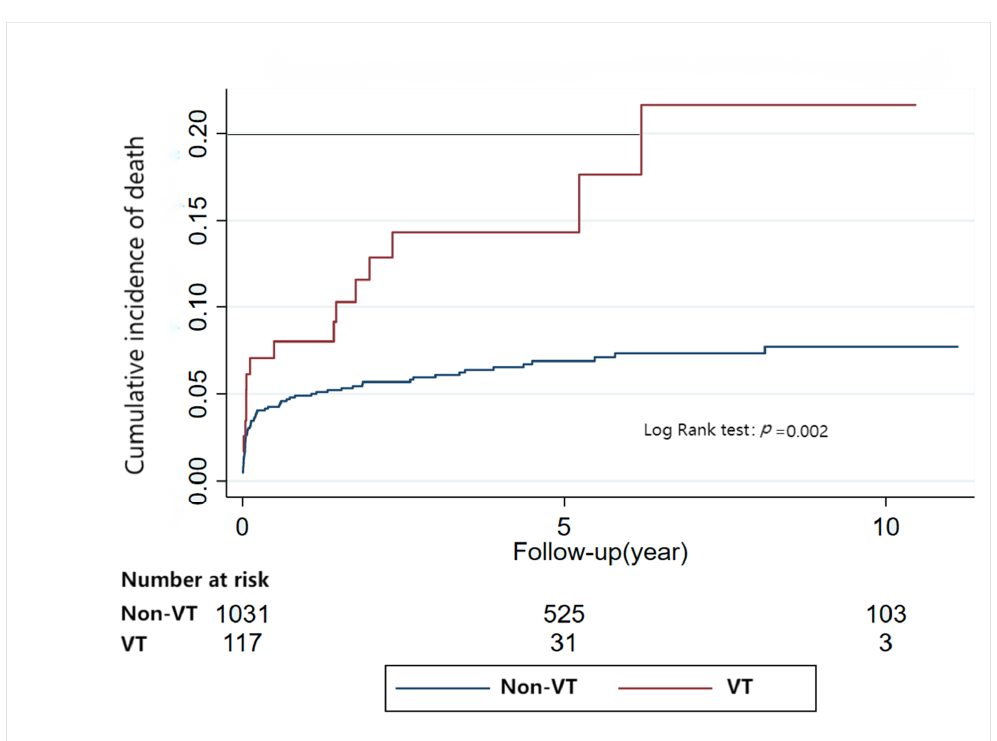
Figure 4. Relationship between ventricular tachycardia and mortality risk in restrictive cardiomyo- pathy (Kaplan-Meier Analyses).